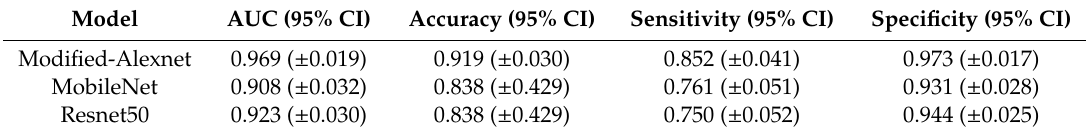
Table 2. Orthognathic surgery screening performance of three models in this study.